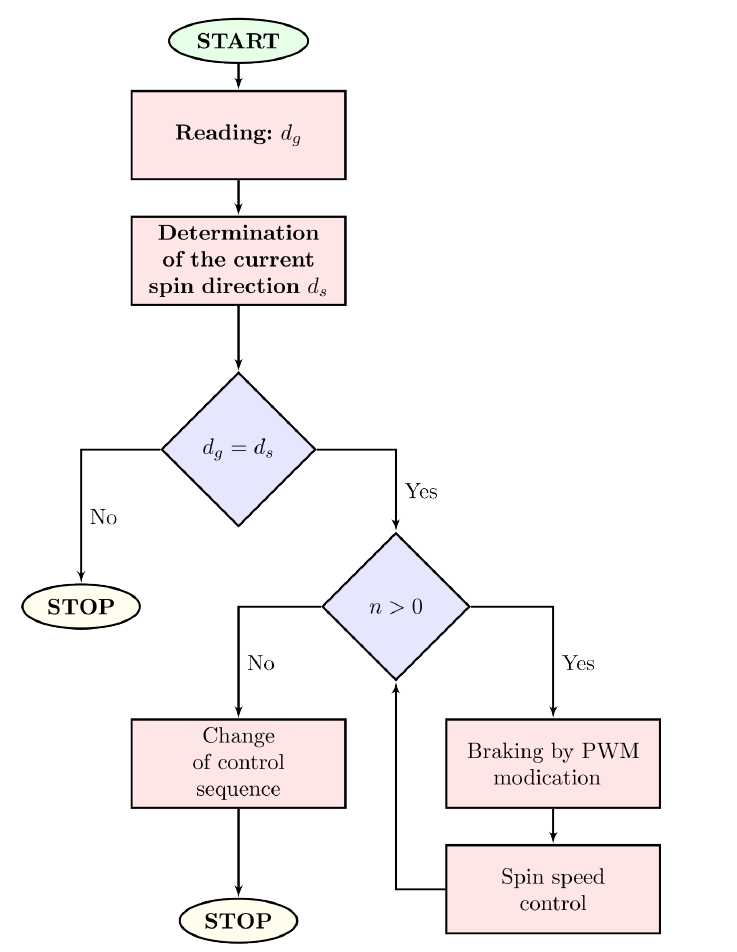
Figure 24. Block diagram of the microcontroller program responsible for the change of the direction of the motor rotation.